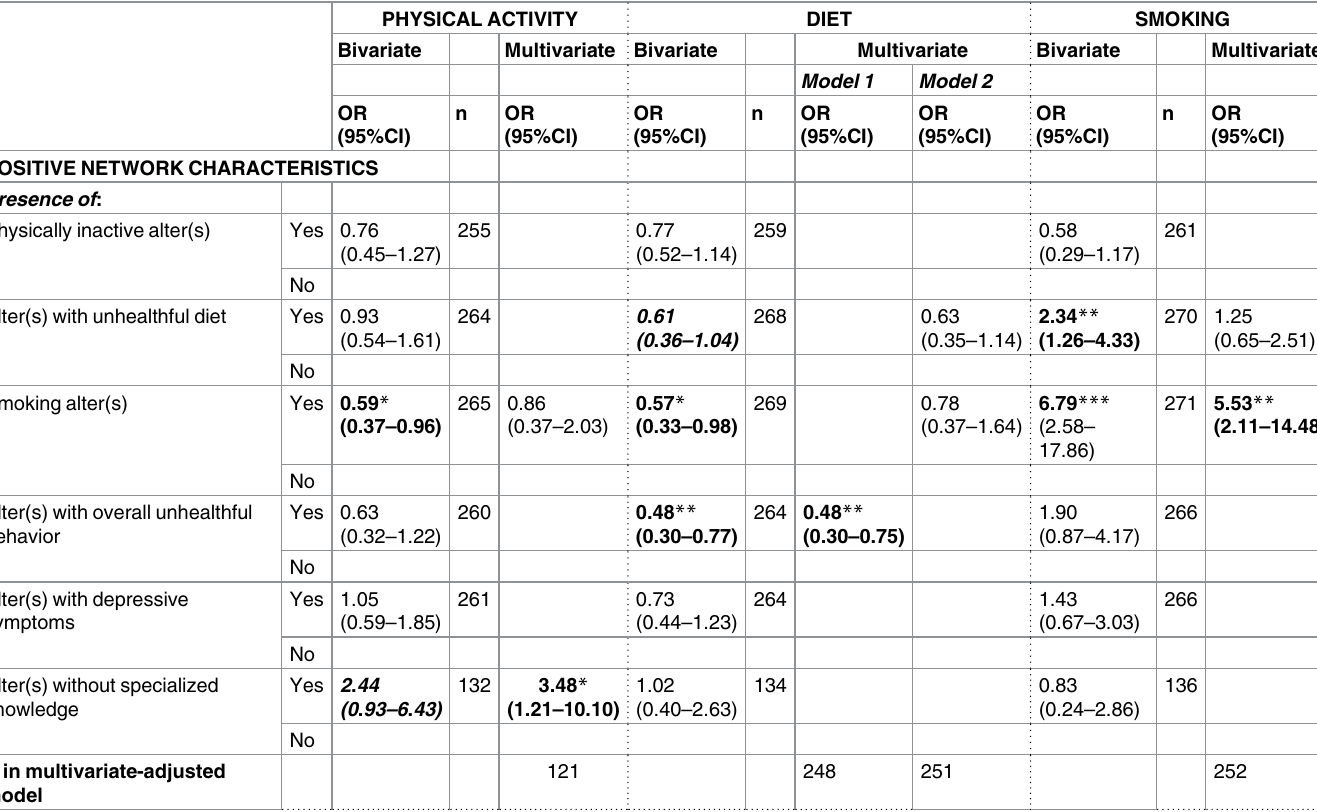
Table 3. Negative social network composition & patient health